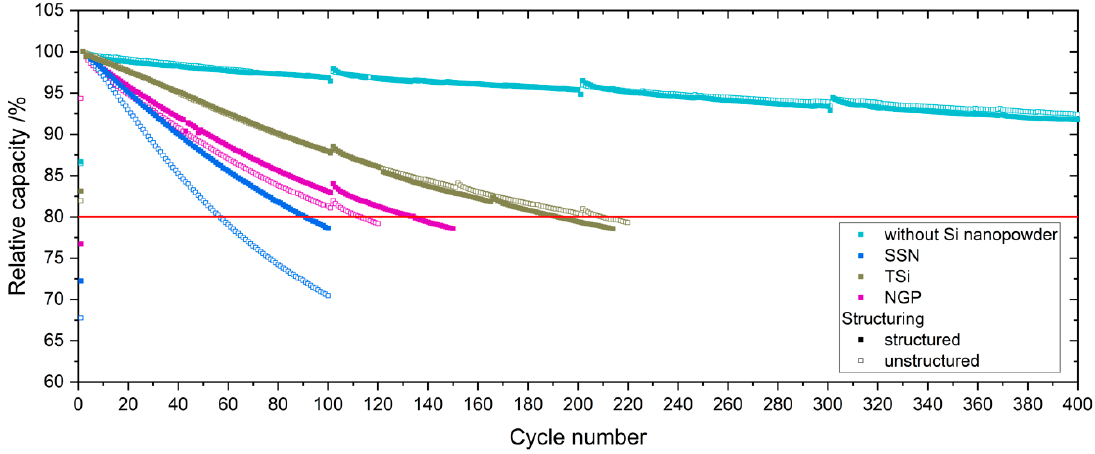
Figure 8. Relative capacity of the pouch cells during lifetime analysis at 1C/1C.